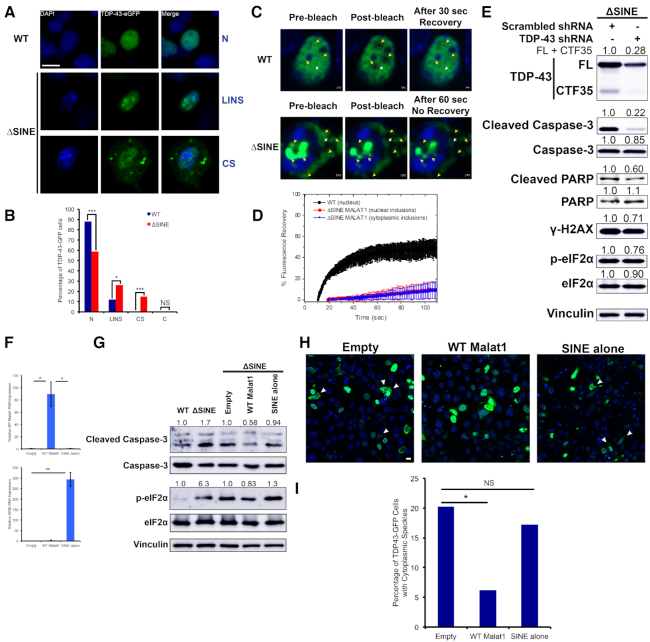

Malat1 ΔSINE induces apoptosis through induction of TDP-43 aggregation. (A) Exogenously expressed full-length TDP-43 forms nuclear and cytoplasmic speckles with irregular shapes in ΔSINE cells, indicative of aggregate formation instead of liquid–liquid phase separation, which has a round shape. Live images of cells transfected with the full-length TDP-43-GFP construct (scale bar = 10 μm). N, cells with only nuclear TDP-43 but no speckle or just a few tiny round ones; LINS, cells with large irregular shaped nuclear TDP-43 speckles; CS, cells with cytoplasmic TDP-43 speckles. Note that cells with these speckles appear unhealthy, possibly undergoing apoptosis. (B) Cells with large irregular shaped nuclear and cytoplasmic TDP-43 speckles are significantly more prevalent in ΔSINE cells, and cells with only nuclear TDP-43 are not as common in ΔSINE cells compared with WT cells, suggesting an increase in cytoplasmic localization of TDP-43. Quantification of cells with different TDP-43-GFP localization patterns. N, cells with only nuclear TDP-43 but no speckle or just a few tiny round ones; LINS, cells with large irregular shaped nuclear TDP-43 speckles; CS, cells with cytoplasmic TDP-43 speckles; C, cells with only cytoplasmic TDP-43 but no detectable speckle. Pearson's chi-squared test was used for comparison. **P < 0.01; ***P < 0.001; NS, not significant (P > 0.05); n ≈ 155 cells for each group. (C) Malat1 ΔSINE dramatically promotes the formation of insoluble aggregates of TDP-43,. Images of FRAP analysis for TDP-43-GFP in WT and ΔSINE cells (scale bar = 1 μm). Yellow arrows indicate photobleached areas. White arrows indicate areas without photobleaching as references. Note that both nuclear and cytoplasmic TDP-43-GFP in ΔSINE cells could not recover GFP signal even 60 s post bleaching, whereas 30 s was sufficient for GFP to fully recover in WT cells. (D) Time-lapse quantification of TDP-43-GFP fluorescence recovery after photobleaching, demonstrating a drastic reduction in the liquid-like property of TDP-43 in ΔSINE cells. (E) TDP-43 depletion rescues apoptosis in ΔSINE cells, suggesting that TDP-43 aggregation is the cause of cellular toxicity. Western blots on lysates from ΔSINE cells stably expressing scrambled shRNA or TDP-43 shRNA. Shown is a representative of 3 biological replicates. (F) Stable overexpression of WT Malat1 and the SINE alone in ΔSINE cells. Overexpression relative to the empty vector was confirmed with qPCR. *P < 0.05; **P < 0.01; error bars indicate standard deviation; n = 3 biological replicates. (G) WT Malat1 overexpression rescues apoptosis and reduces eIF2α phosphorylation in cells with the mutant Malat1 ΔSINE, suggesting that SINE deletion causes a loss of function of Malat1. WT and ΔSINE cells serve as reference controls. Shown is a representative of three biological replicates. (H) Overexpression of WT Malat1 reduces formation of cytotoxic TDP-43 cytoplasmic speckles in ΔSINE cells. Live images of cells transfected with the full-length TDP-43-GFP construct (scale bar = 10 μm). (I) Quantification of the percentage of TDP-43-GFP cells with cytoplasmic speckles in ΔSINE cells with overexpression of WT Malat1 or the SINE alone. Pearson's chi-squared test was used for comparison. *P < 0.05; NS, not significant (P > 0.05); n ≈ 100 cells for each group.